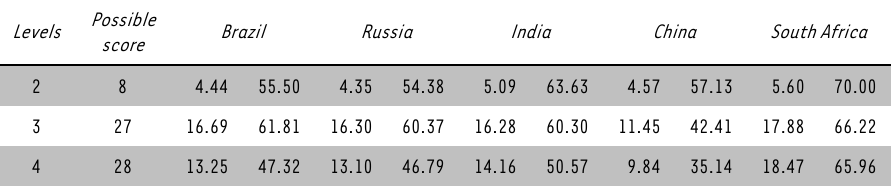
TABLE 8: Element 6 - Governance structures Possible Levels Brazil score